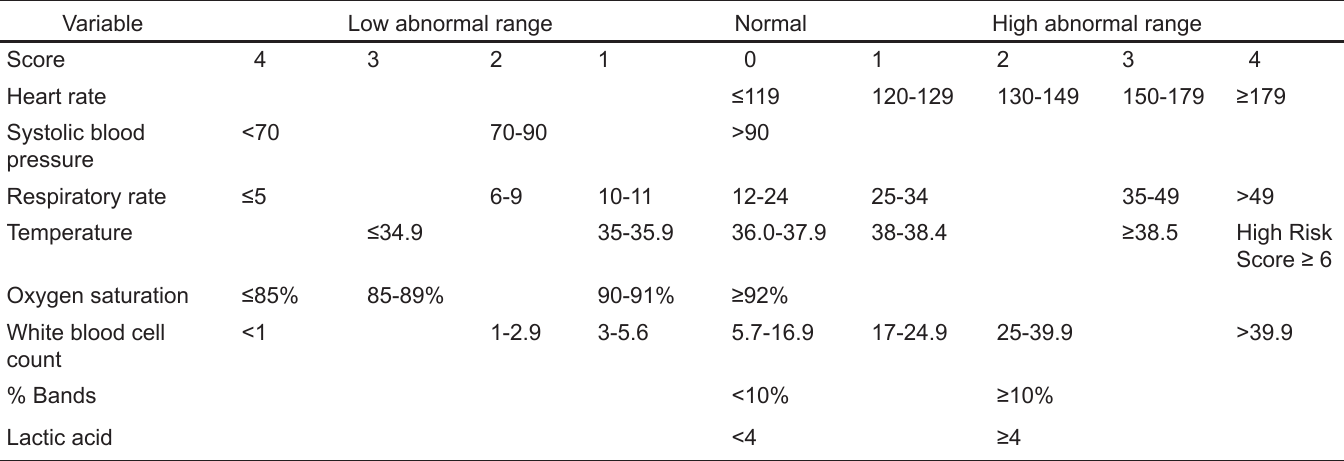
Table 3. The Sepsis in Obstetrics Score (SOS) scoring criteria.